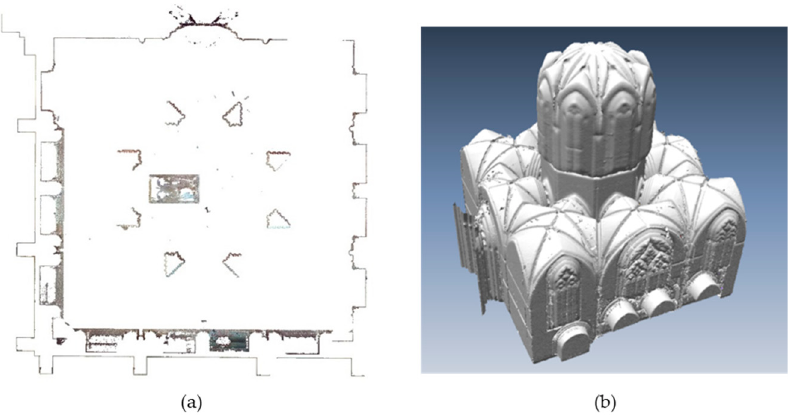
Figure 11. Founder’s Chapel: ( a ) floor plan view in Autodesk Revit, ( b ) 3D model after indoor cloud registration.